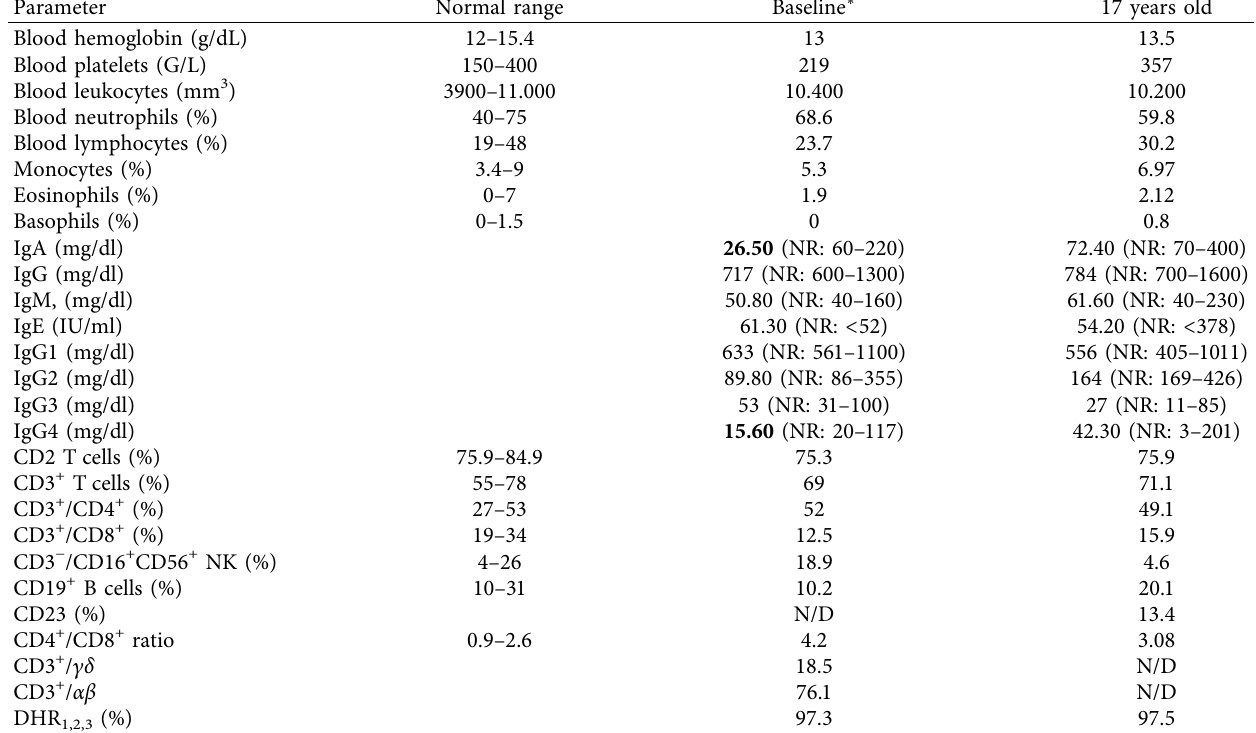
Table 2: Summary of the patient’s immunological profile.